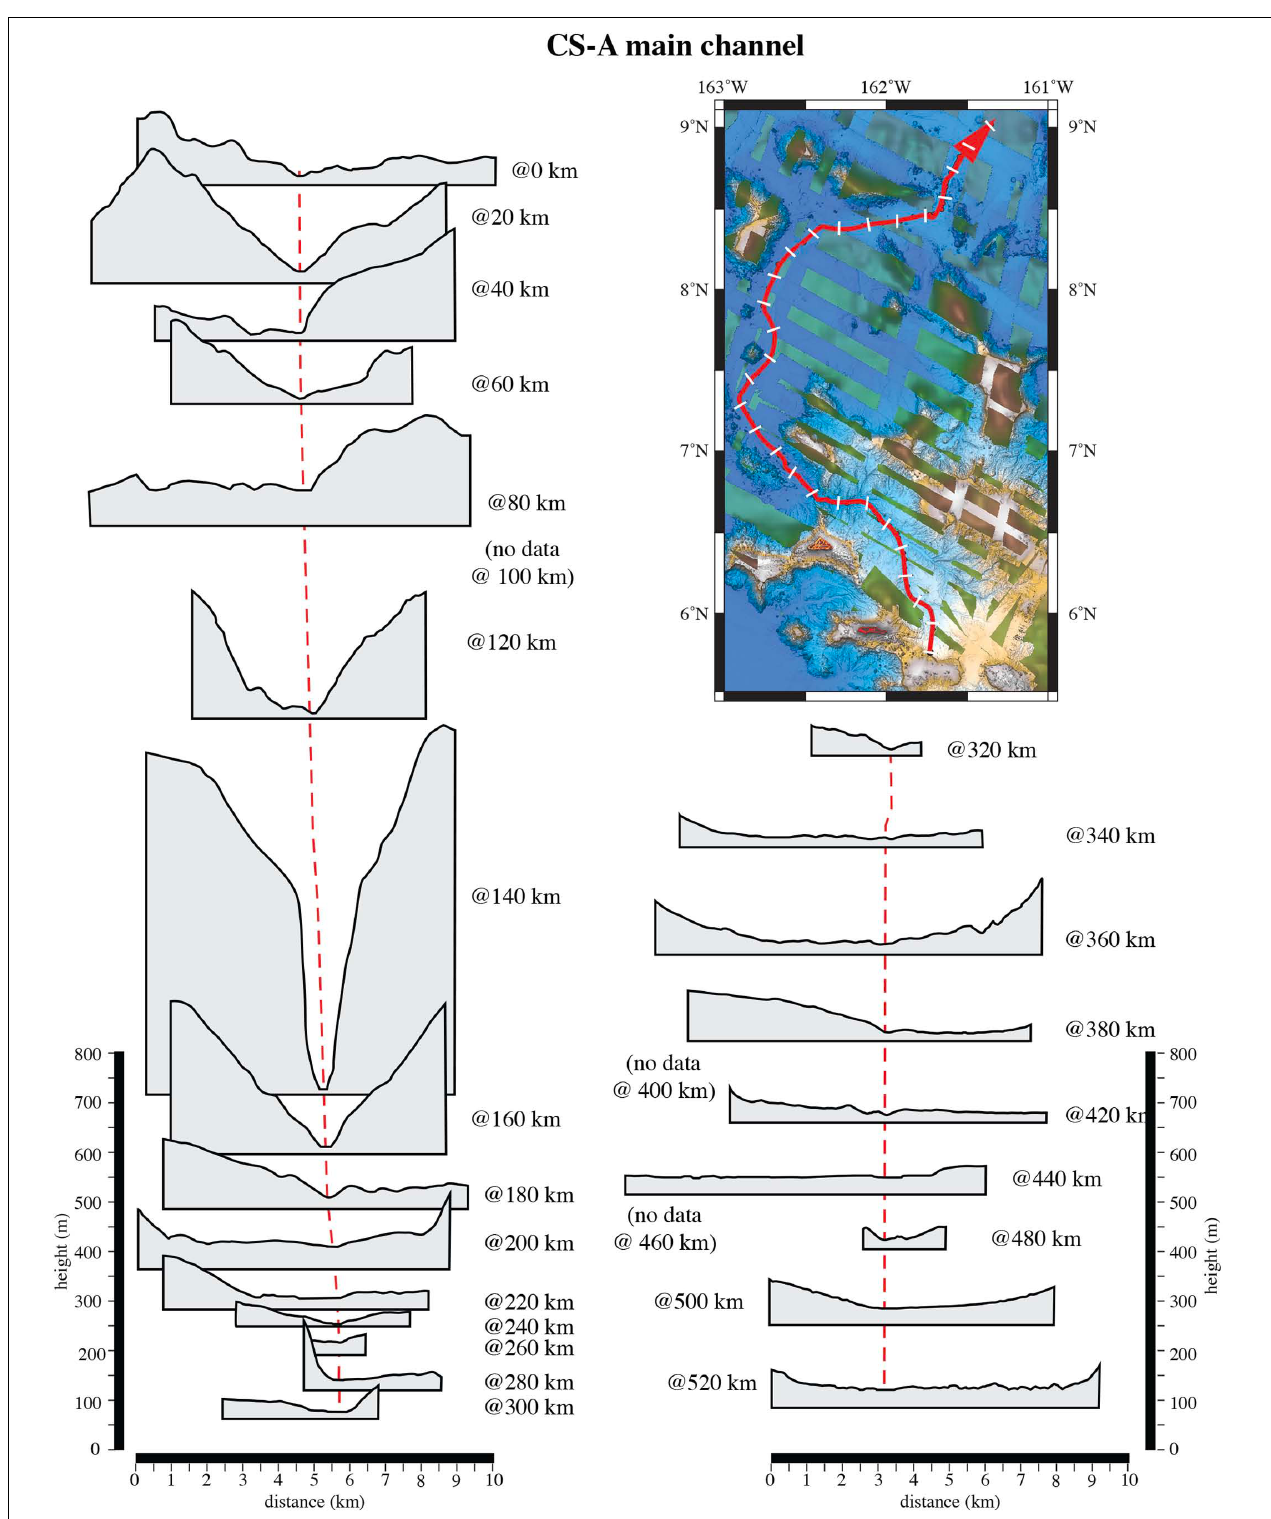
FIGURE 7 | Stacked cross-channel profiles at 20-km intervals down the main channel of CS-A. Map inset shows locations of cross-channel profiles (white lines perpendicular to red main channel). Vertical exaggeration of profiles is 14 × . Red dashed lines connect channel thalweg.